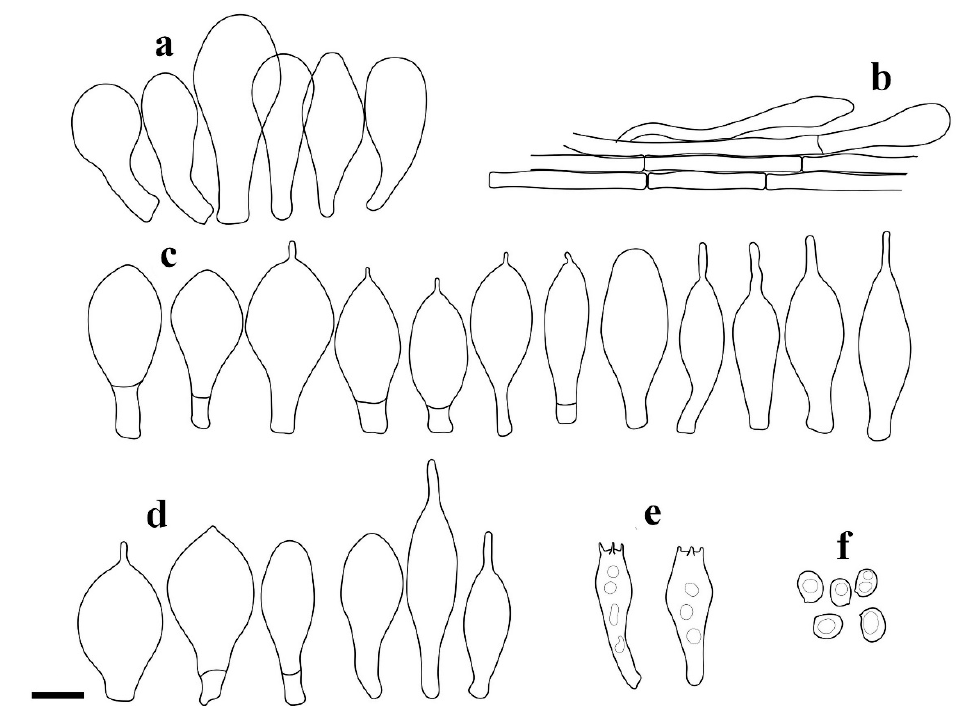
Figure 7. Pluteus farensis holotype GDOR 5085: ( a ) pileipellis elements; ( b ) caulocystidia; ( c ) cheilocystidia; ( d ) pleurocystidia; ( e ) basidia; ( f ) spores. Scale bar 10 µm. Pluteus flavostipitatus E.F. Malysheva sp. nov. (Figures 8 and 9) MycoBank number: MB843561